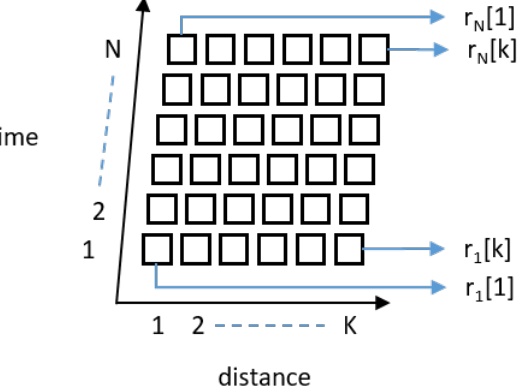
Figure 3. Creation of the IR-UWB radar data matrix comprising K fast-time indexes representing each row and N slow-time indexes representing each column.